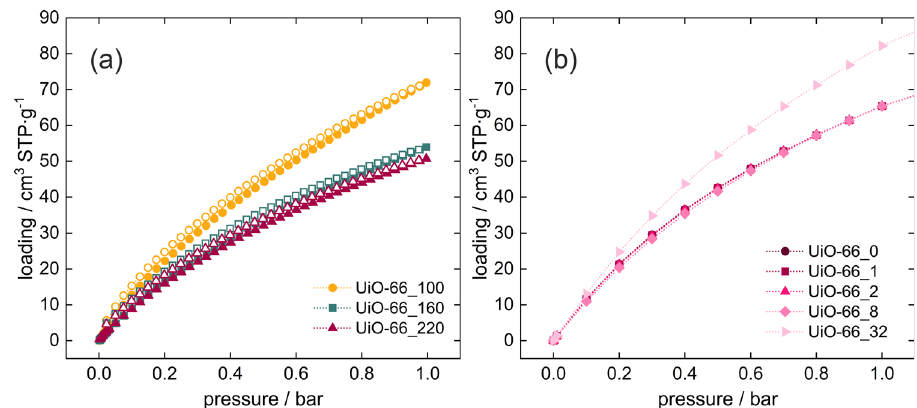
Fig. 2 Adsorption isotherms for carbon dioxide in UiO-66. a From experiment, b from calculations, measured/computed at 27 °C. Closed symbols stand for adsorption, open for